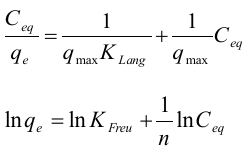
Table 2: The kinetic constants for the adsorption of metal ions on CaCO 3 nanopaticles